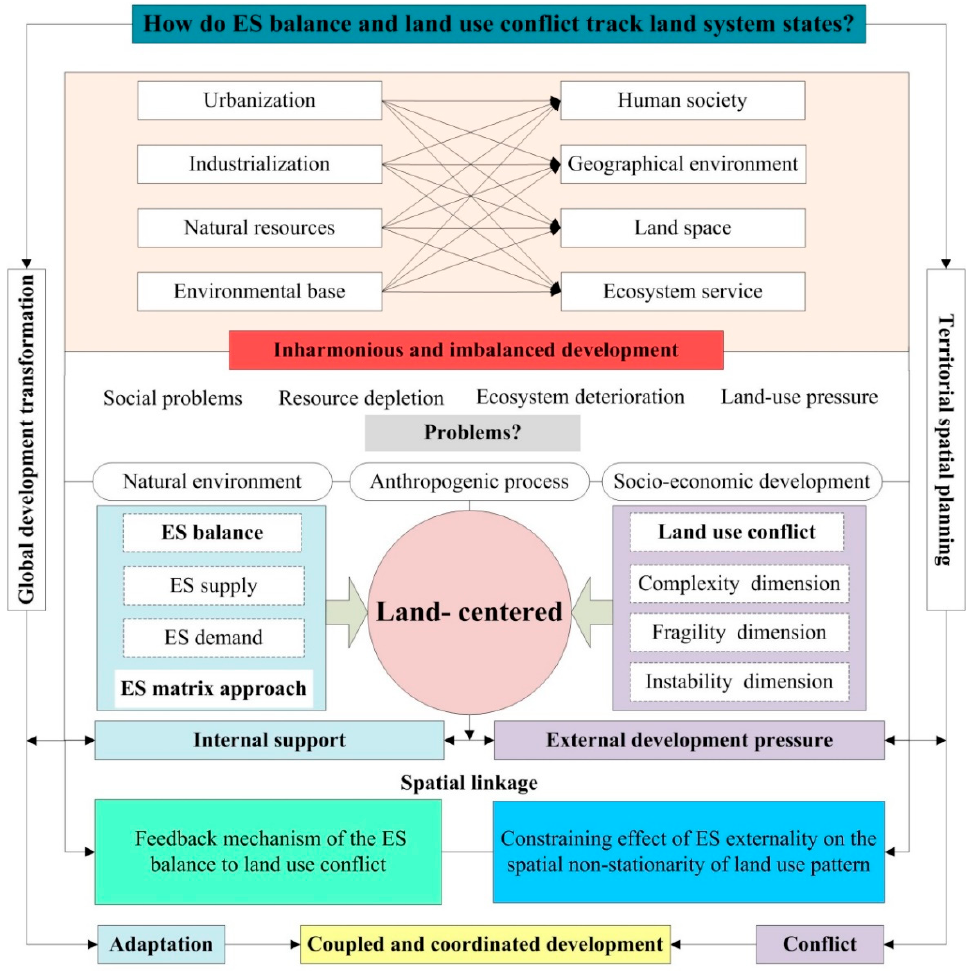
Figure 9. The logic diagram of combining ES balance and land use conflict to track land system states.